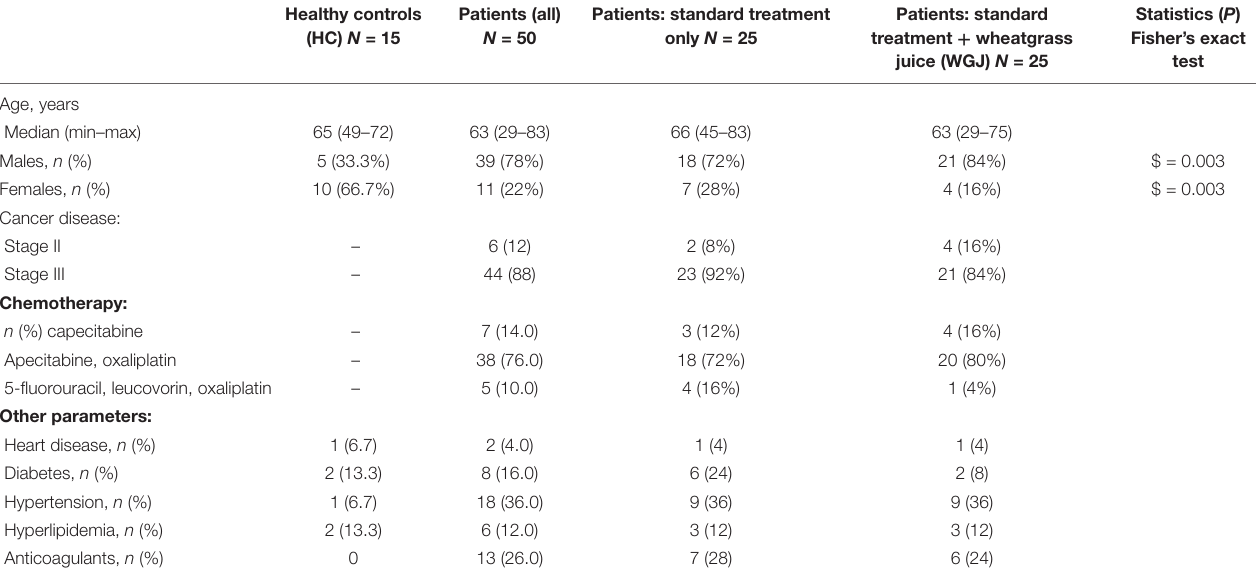
TABLE 1 | Patient characteristics.